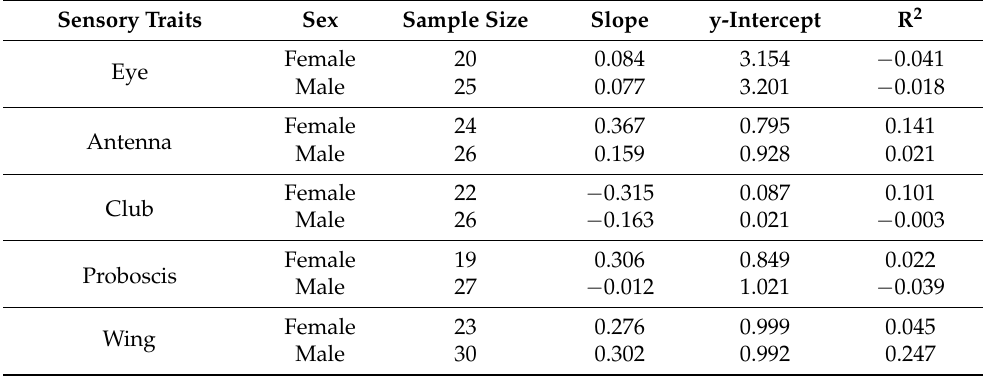
Table 1. Allometric slopes of the sensory traits in relation to body size in females and males Pieris napi . Sensory Traits Sex